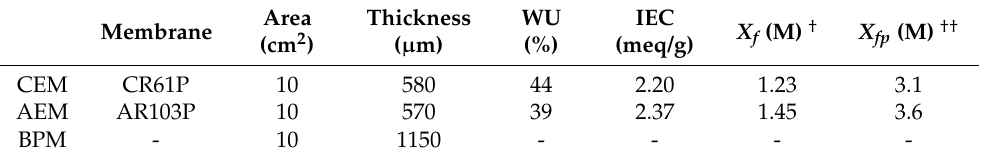
Figure 2. Schematic of BPED process with BCA as a repeating unit (RU). Table 1. Membrane’s characteristics [34].